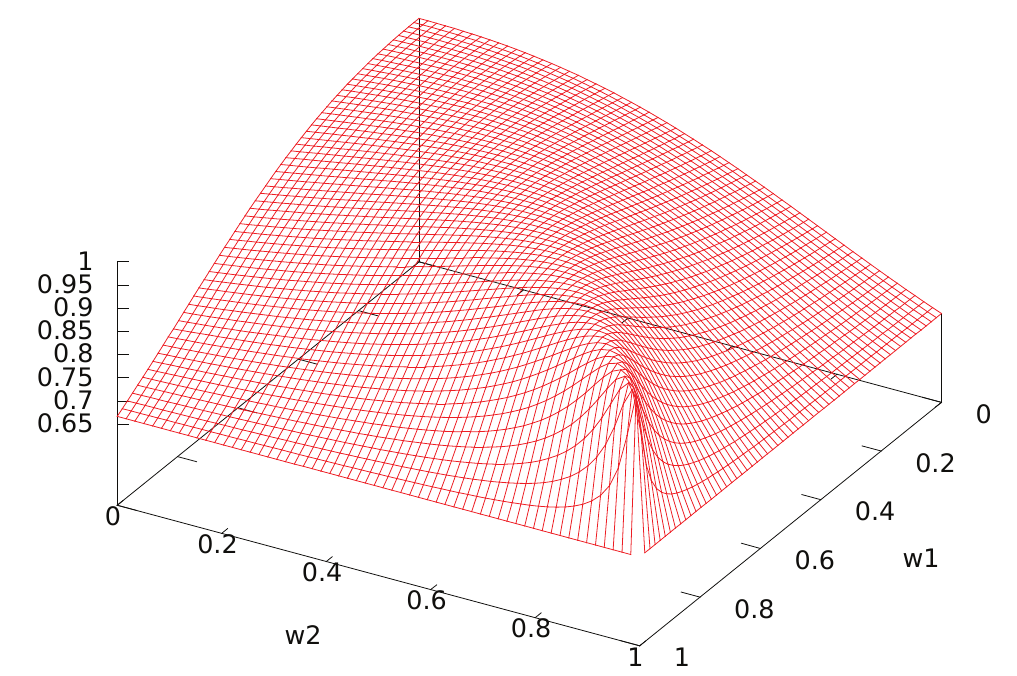
Figure A3. Amplitude of probability of transition.